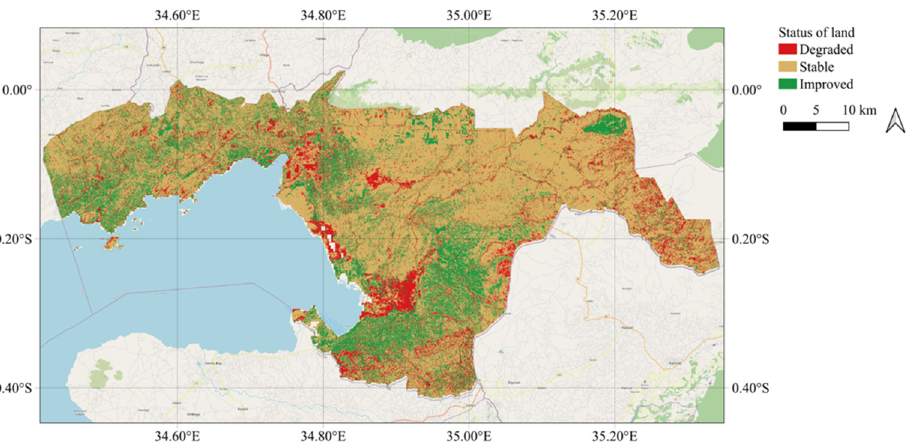
Figure 6. The extent of land status (degraded, stable or improved) (SDG 15.3.1) between 2016 and 2020 in Kisumu, Kenya.